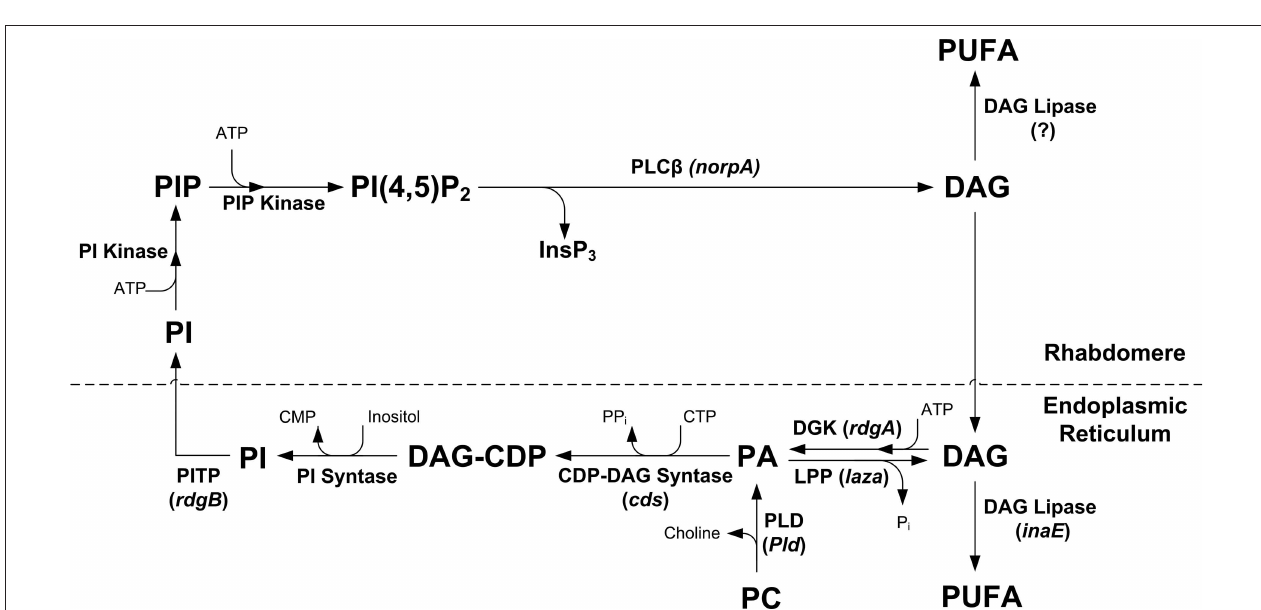
This slow response termination can be resolved into continuous production of bumps in the dark at a later time (inset, at higher magnifi cation). (C) Electroretinogram (ERG) responses showing superimposed traces recorded from wild-type and norpA P76 (a weak norpA allele) to a brief fl ash (red arrow) and continuous light. The graph plots the relative steady state amplitude of the ERG to prolonged lights as a function of relative light intensity. The ERG responses of norpA P76 to a brief fl ash and to continuous light are indistinguishable.